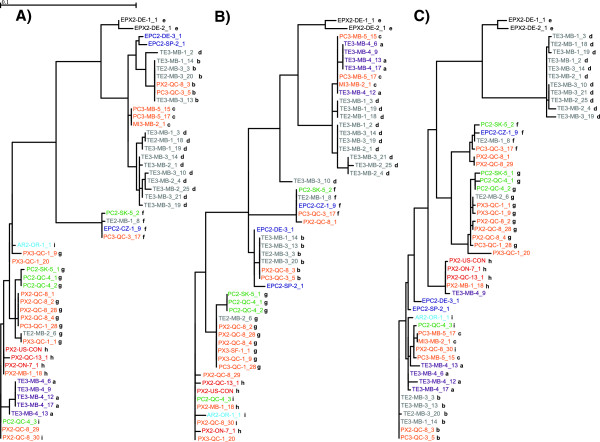
Unrooted dendrograms of 53 partial Pokey sequences from isolates of the Daphnia pulex complex. (A), (B) and (C) represent trees constructed from three regions of recombinant Pokey sequences (bp 1 to approximately bp 540, bp approximately 540 to approximately bp 820, and bp approximately 820 to approximately bp 1,450, respectively) defined by recombination breakpoints identified by GARD analysis. Colors represent species or hybrid state of isolates: red = D. pulex, light blue = D. arenata, grey = D. tenebrosa, black = European D. pulex, dark blue = European D. pulicaria, green = D. pulicaria, orange = putative pulex-pulicaria hybrids, purple = the isolate with D. tenebrosa mtDNA and a D. pulex nuclear genome. GARD, Genetic Algorithm for Recombination Detection.